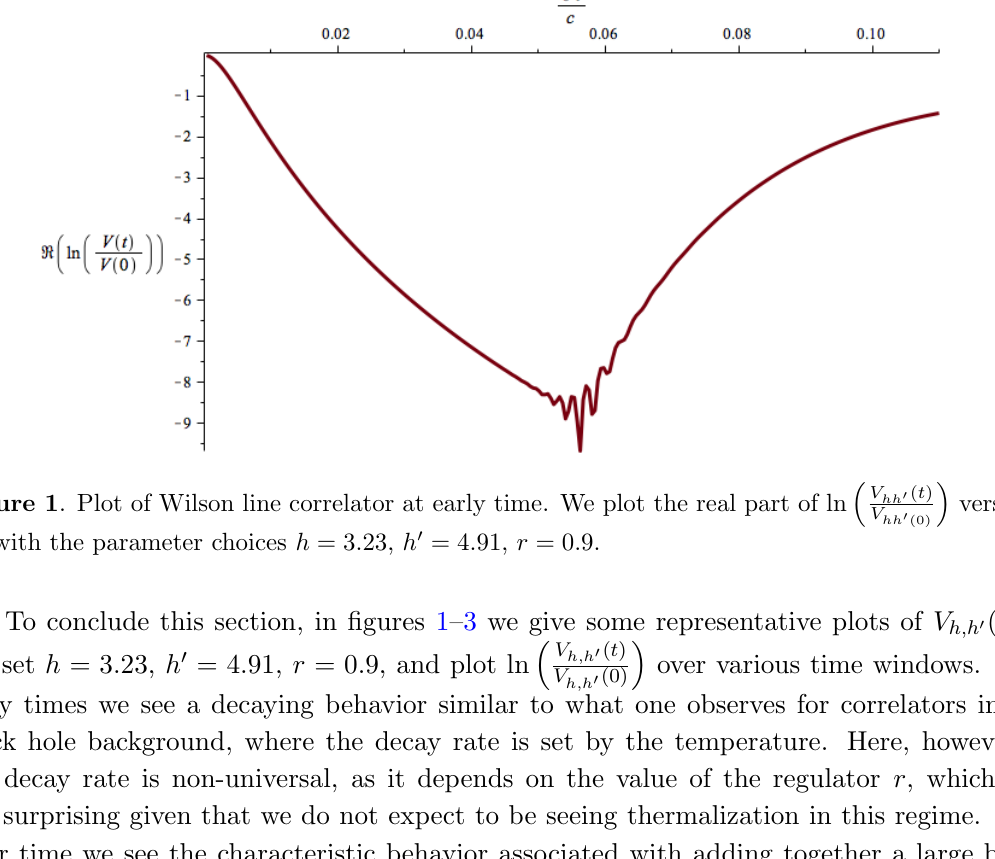
Figure 1 . Plot of Wilson line correlator at early time. We plot the real part of ln 6 t , with the parameter choices h = 3 : 23, h 0 = 4 : 91, r = 0 : c